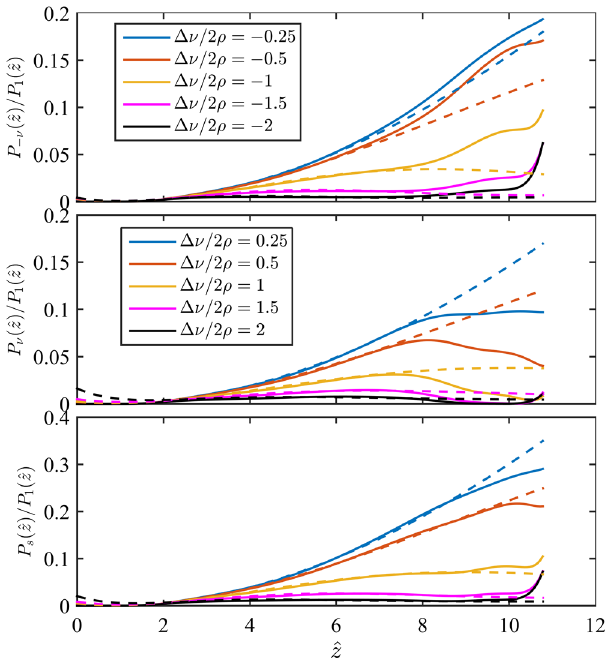
FIG. 3. The predicted power ratio of the lower sideband to the seed along the undulator for different energy modulation ampli- tudes in 1D simulations (squares). The energy modulation wavelength is 8 μ m and the corresponding Δ ν = 2 ρ ¼ − 0 . 16 . All dashed lines are theory predictions from Eq. (25).